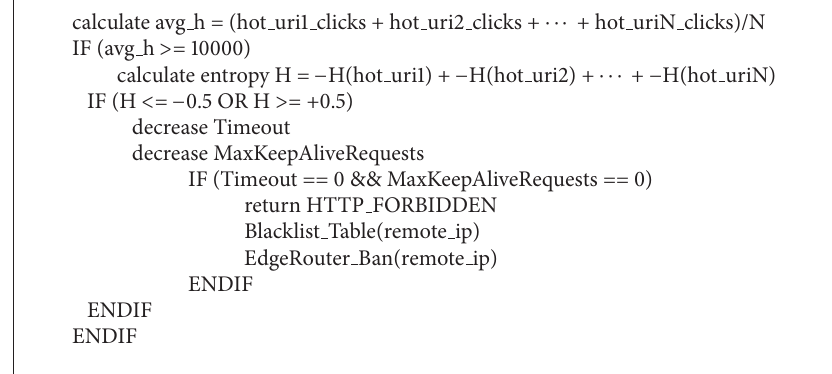
Algorithm 6: Flash crowd attack entropy algorithm.